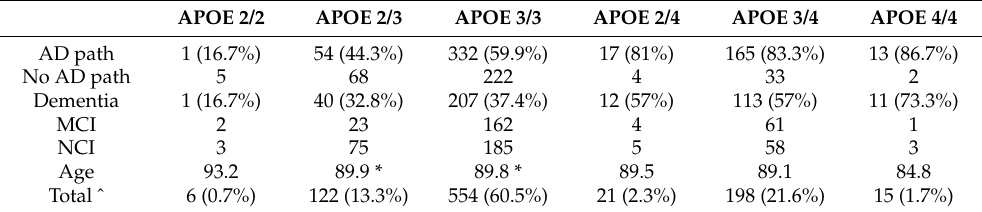
Table 1. Total number of subjects per clinical and AD pathology diagnostic group within each APOE genotype in the 916 ROSMAP subjects used in the machine learning